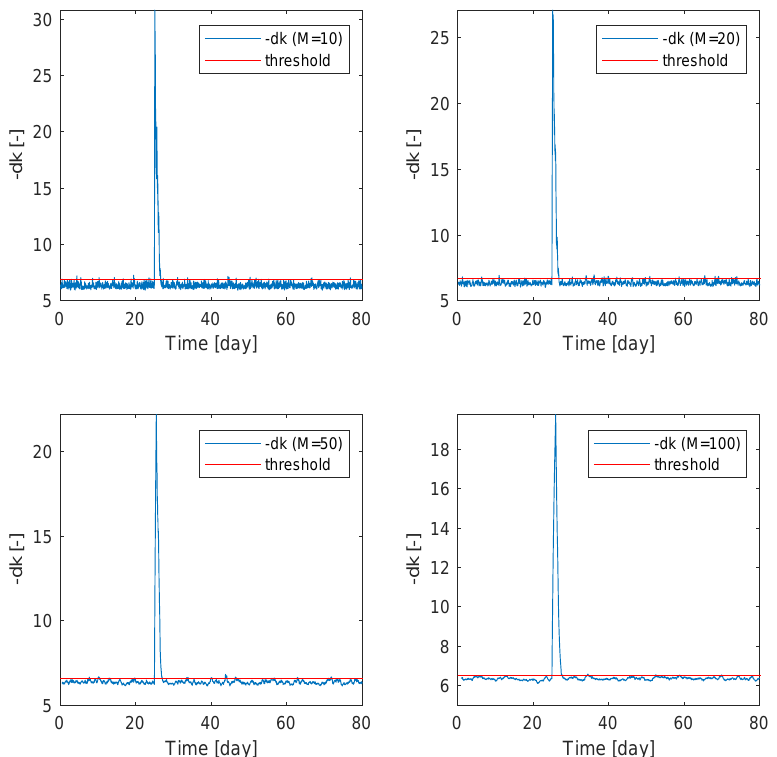
Figure 15. Sensitivity analysis by the sliding window ( M ): impact faults. The fault occurs from the 25th to the 26th day. M = 10, 20, 50, and 100 time steps. The 15% fault was used, that is, 990 mg MLSS/L. T =